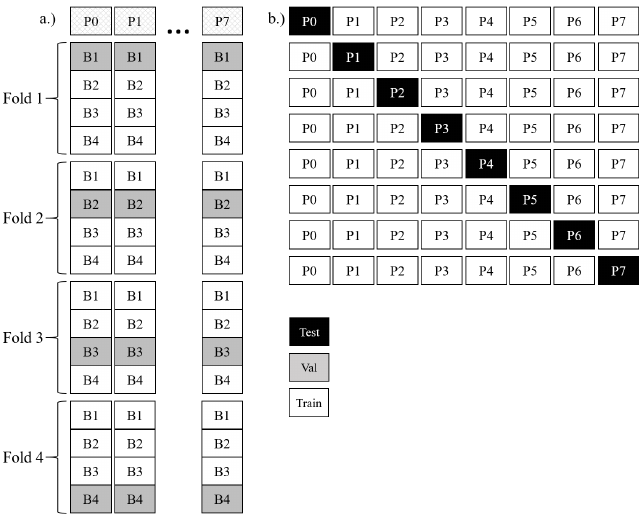
Figure 4. Ensemble Training: ( a ) 4-fold cross-validation across blocks was performed to tune hyperparameters for each within-participant model. Each of the models from these folds was also used as members of an ensemble of by-participant ensembles rather than continuing with part b; ( b ) Next, using each participant separately as the hold-out test set, the remaining individuals were used to train individual models using the hyperparameters derived from their individual model tuning in part a. Participants are not connected as they are in Figure 3 to highlight that they are each trained